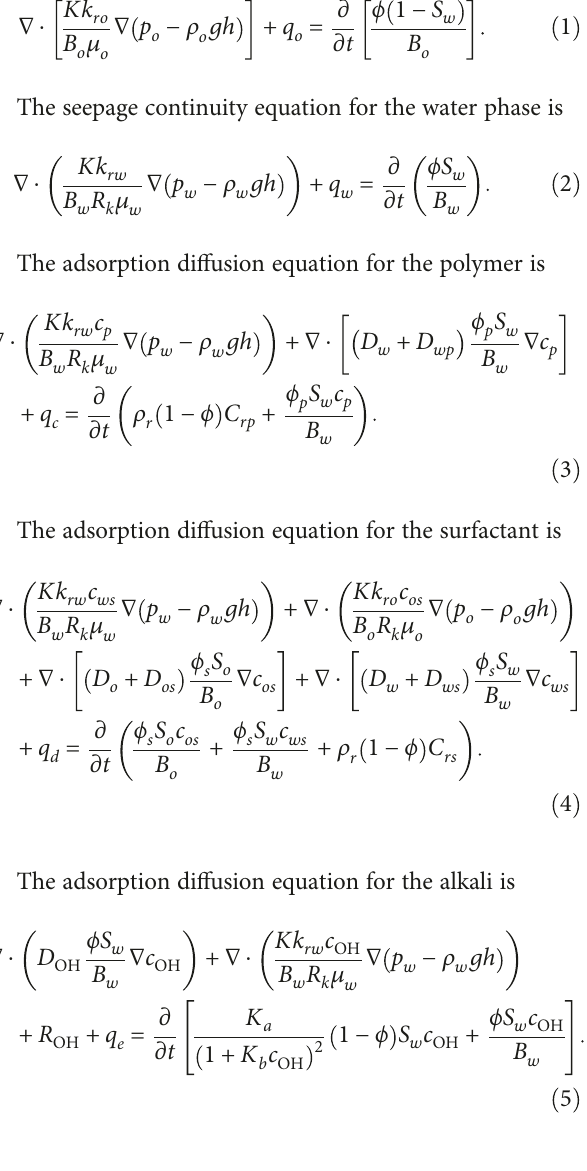
Figure 1: Three-slug injection scheme. The slug size is the injection concentration, and the slug length is the injection time of displacing